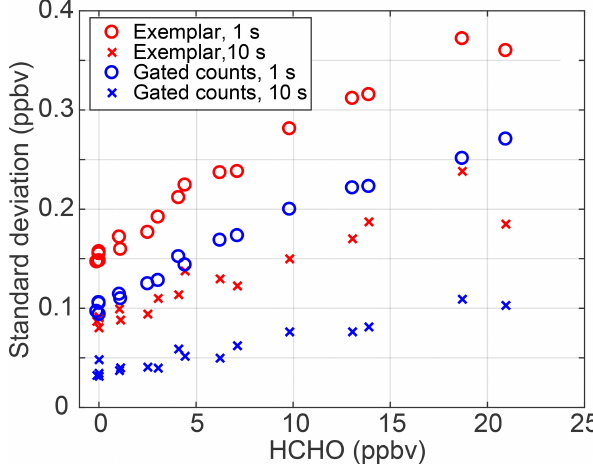
Figure 6. Standard deviation as a function of HCHO for two data processing techniques: exemplar fitting for 1s (red circle) and 10s (red x) data, and gated counts for 1s (blue circle) and 10s (blue x)